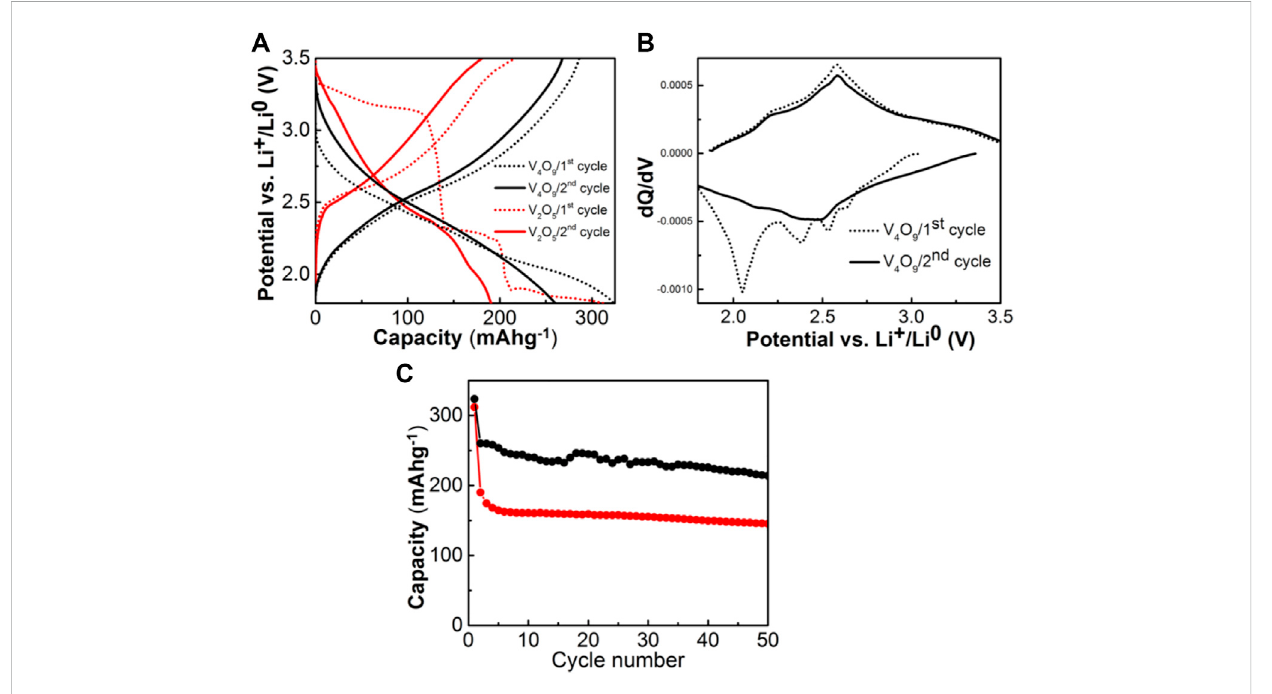
FIGURE 3 (A) Voltage pro fi les of Li/V 4 O 9 & Li/V 2 O 5 cells at C/10 rate in between 1.8 and 3.5 V capacity vs. cycle number plots of V 4 O 9 and V 2 O 5